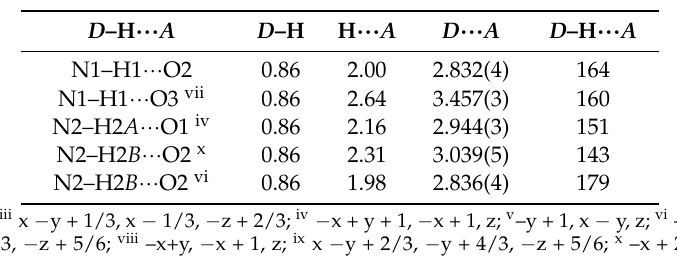
Table 5. Hydrogen-bond geometry (Å, ◦ ) for